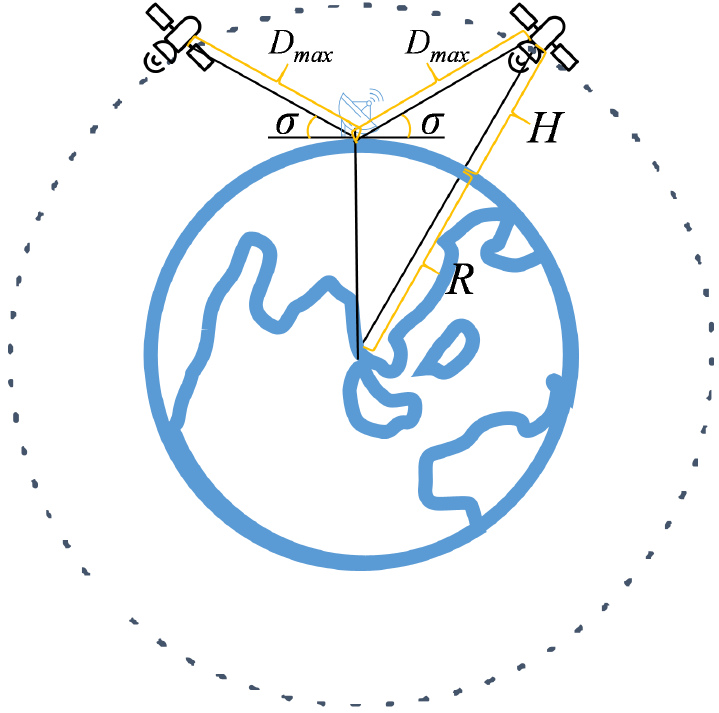
Figure 3. Parameters in Equation